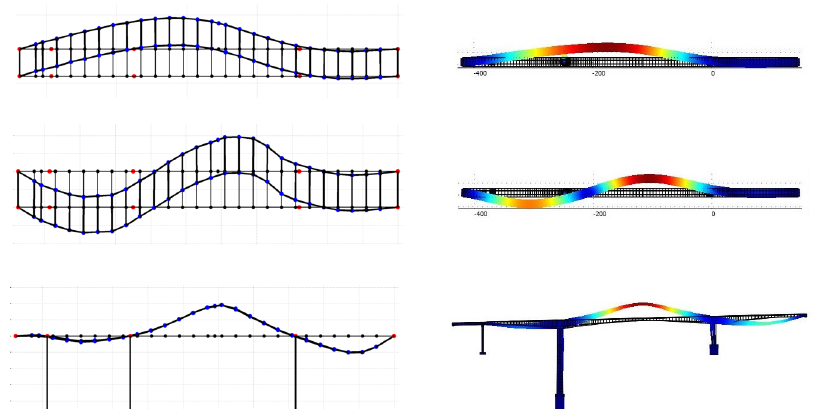
Figure A1. Comparison between the experimentally identified (left column) and nominal FE model predicted (right column) mode shapes of the Metsovo bridge. Modes 1–3.